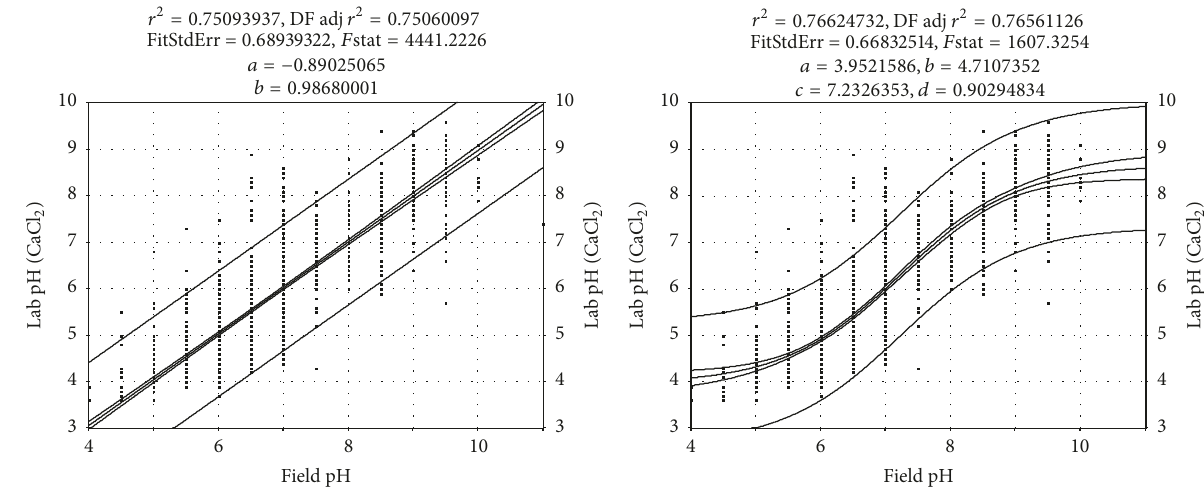
(b) Sigmoidal model (original data) for field pH F versus pH C with least- squaresminimisationand95 % CI(narrowband)and95 %